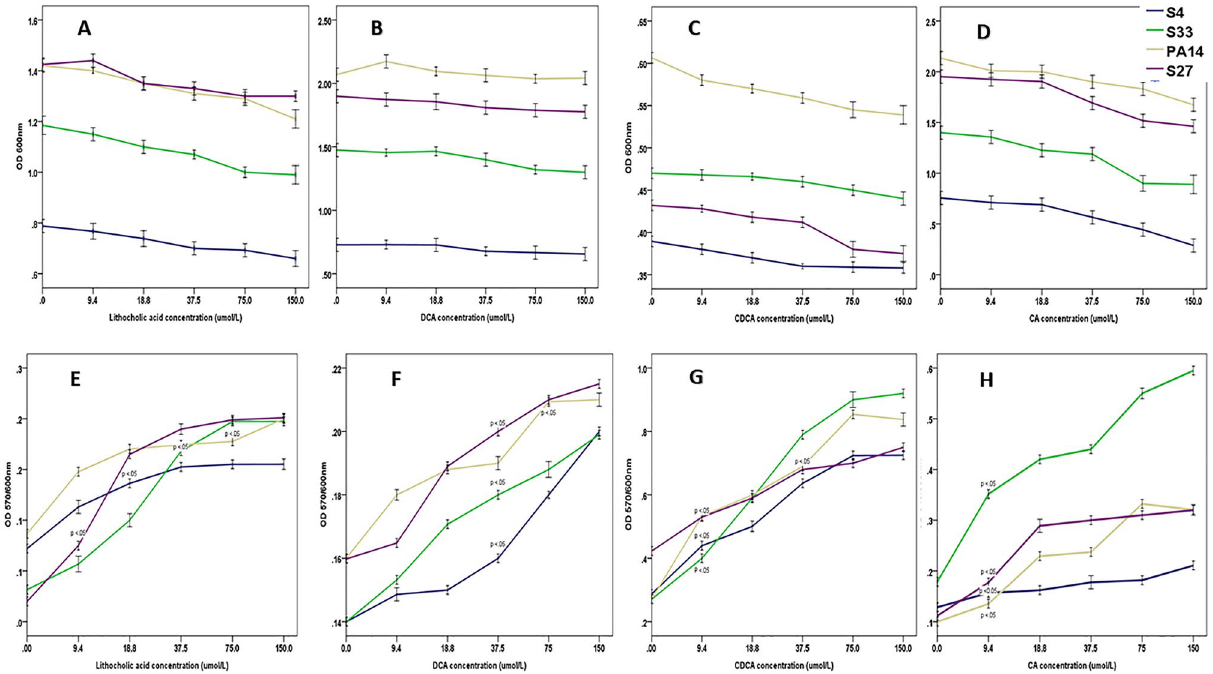
Figure 4. The impact of different bile acids on Pa growth ( A–D ) and biofilm formation ( E–H ), at concentrations detected in sputum and bronchoalveolar lavage (BAL) in